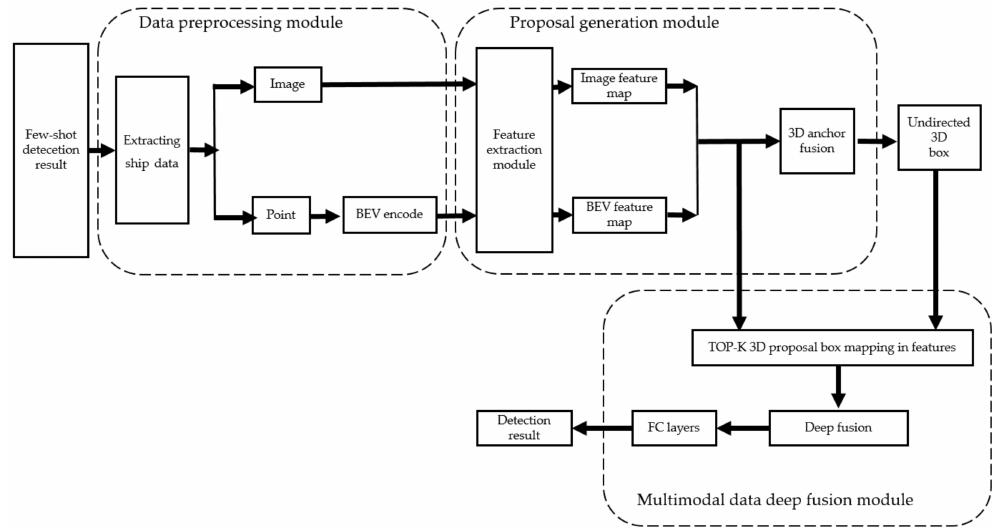
Figure 6. Network structure of water surface key target detection